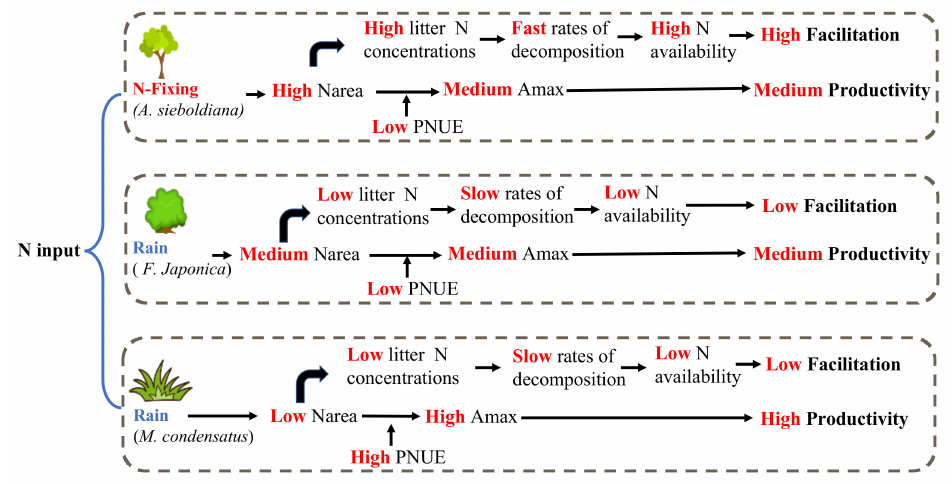
Figure 2. Conceptual figure of the impact of various species on ecosystem functions according to ecophysiological leaf